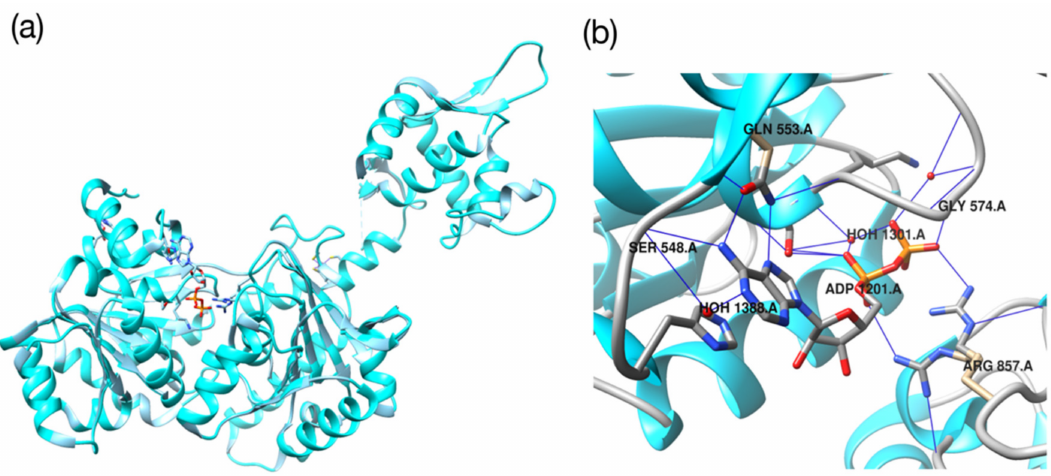
Figure 9. ( a ) Crystal structure of WRN. ( b ) Ligands binding to proteins. Proteins are expressed in the form of blue ribbons and ligands are expressed in the form of sticks. The ligand shown (ADP) is a na-tive ligand of